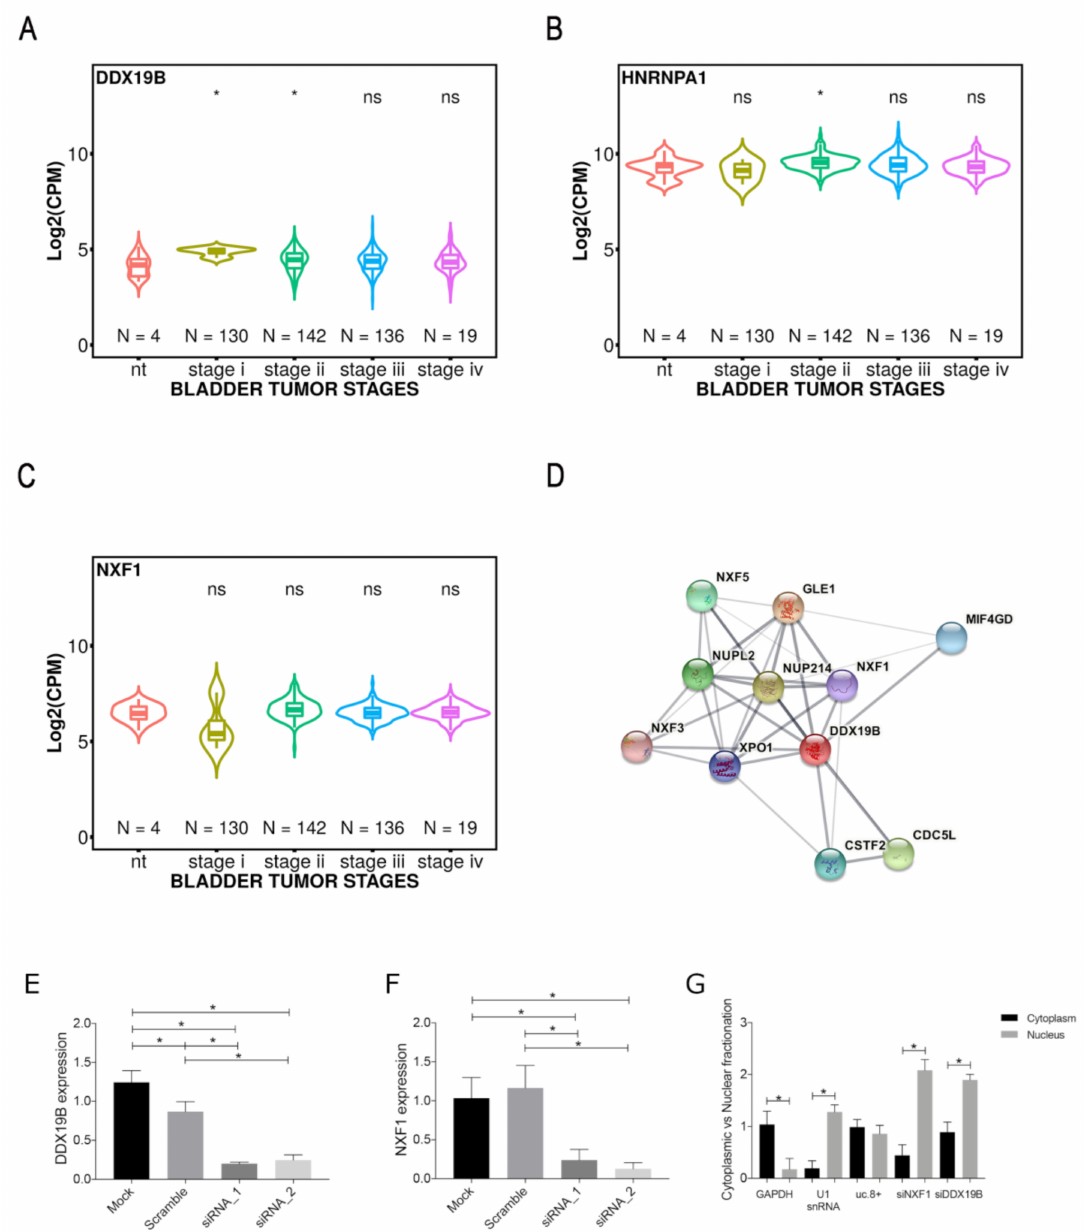
Figure 5. Violin plot for ( A ) DDX19B, ( B ) NXF1 and ( C ) HNRNPA1 expressions (CPM) in TCGA-BLCA project, at different tumor stages. ( D ) network of known and predicted protein-protein interactions for DDX19B and NXF1 as described in the STRING database, line thickness indicates the strength of data support. ( E ) J82 cells were transfected with siRNA_1 and siRNA_2 anti-DDX19B or siRNA scramble. ( F ) J82 cells were transfected with siRNA anti-NXF1_1 and siRNA_2 or siRNA scramble. The DDX19B and NXF1 level was determined by qRT-PCR. ( G ) At 48 h post-transfection with siRNAs targeting DDX19B (siRNA1 + 2) and NXF1 (siRNA1 + 2) the level of uc.8+ was determined by RT-qPCR and expressed as fold change vs. control. Data are expressed as the mean ± SD of triplicate values. * p -values <